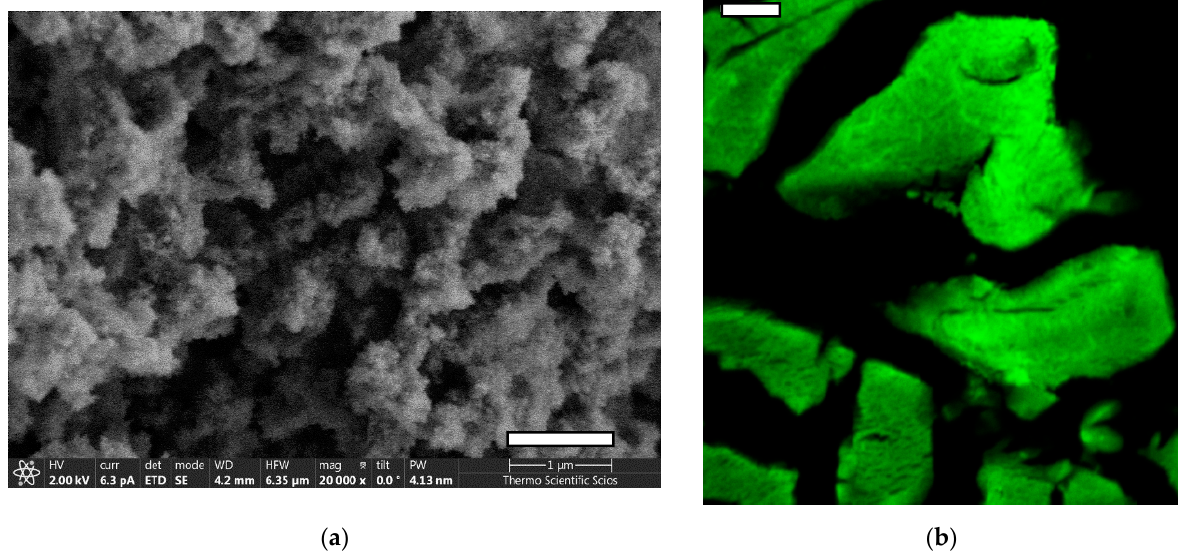
Figure 1. ( a ) Representative SEM image of the fresh fracture surface of fluorescein functionalized silica–gelatin aerogel (FSG). Scale bar: 1 µm. ( b ) Confocal fluorescence microscopy images of paraffin-embedded aerogel particles. Scale bar: 15 µm.